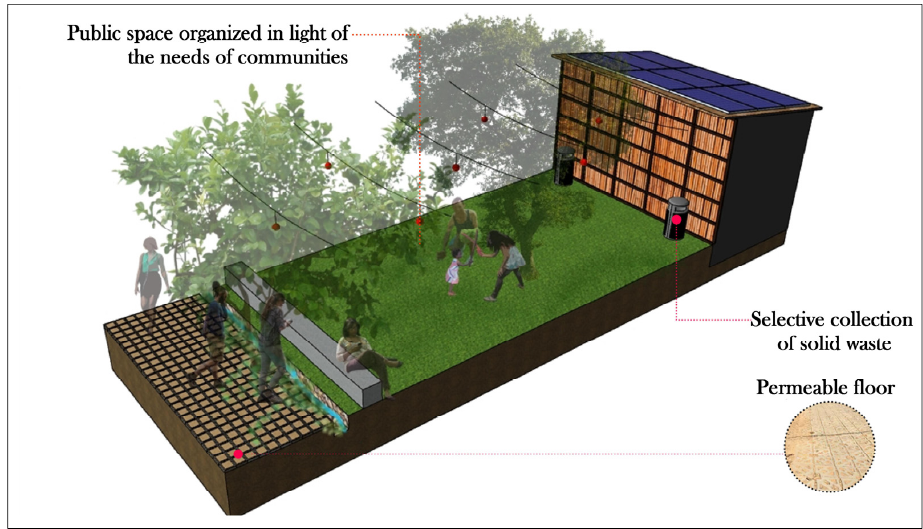
Figure 14. Improvements in infrastructure and public micro spaces.